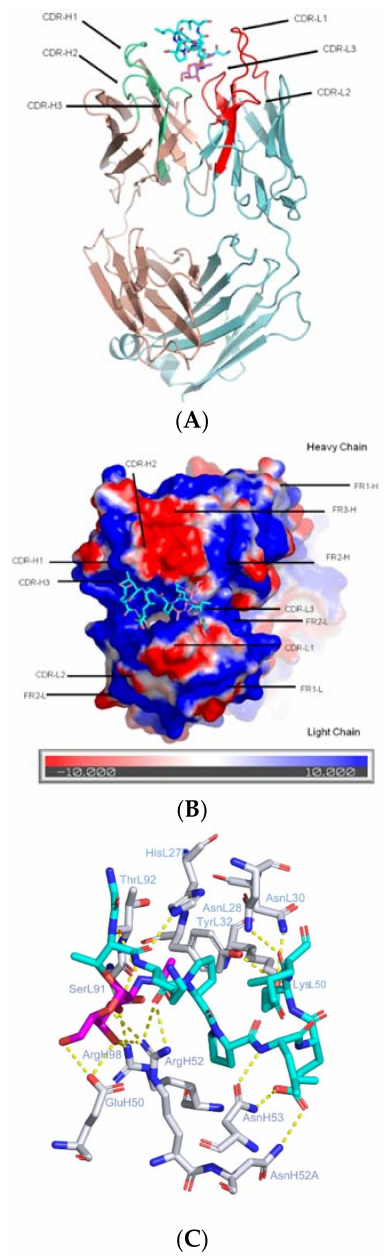
Figure 2. The CDRs of 237 mAb in complexed with tumor-specific glycopeptide of podoplanin. ( A ) The structure of 237 mAb in complex with glycopeptide (ERGT(GalNAc)KPPLEELS) (PDB ID: 3iet): The carbon atoms of glycopeptide are colored in cyan, with the sugar moiety GalNAc highlighted in hot pink (PDB ID: 5t78). The light chain is colored in light blue with CDR loops highlighted in red and labeled. The heavy chain is colored in pink with CDR loops highlighted in lime green. The carbohydrate is wedged in the binding pocket formed by CDRs L3, H1, H2 and H3; ( B ) Electrostatic surface potentials are colored red and blue for negative and positive charges, respectively, and white color represents neutral residues. The orientation of the antibody is adjusted to show the binding of the glycopeptide with more clarity; ( C ) Key interactions of the glycopeptide with the 237 mAb combining site. Hydrogen bond are depicted in yellow dotted lines. The sidechains of 237 mAb were depicted in white ball-and-sticks with the glycopeptide colored in blue. The GalNAc sugar moiety was highlighted in magenta. The residues on CDR heavy chains are labeled with H, those on CDR light chains are labeled with